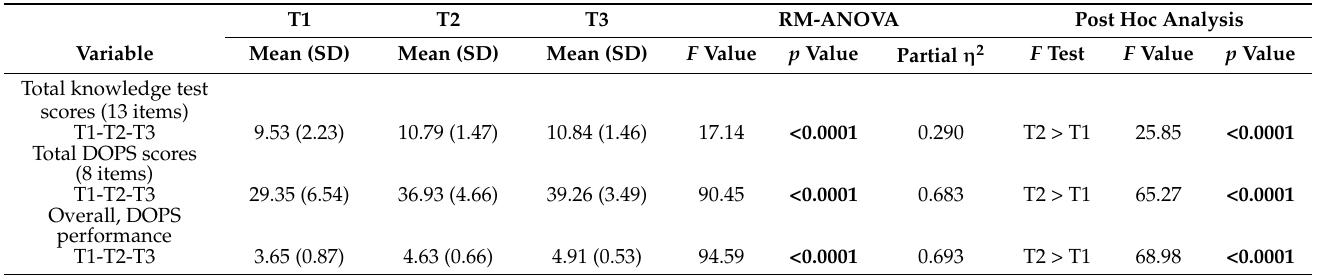
Table A1. Within-subjects effects of using virtual reality for implanted Port-A catheter care training among nurses ( n =